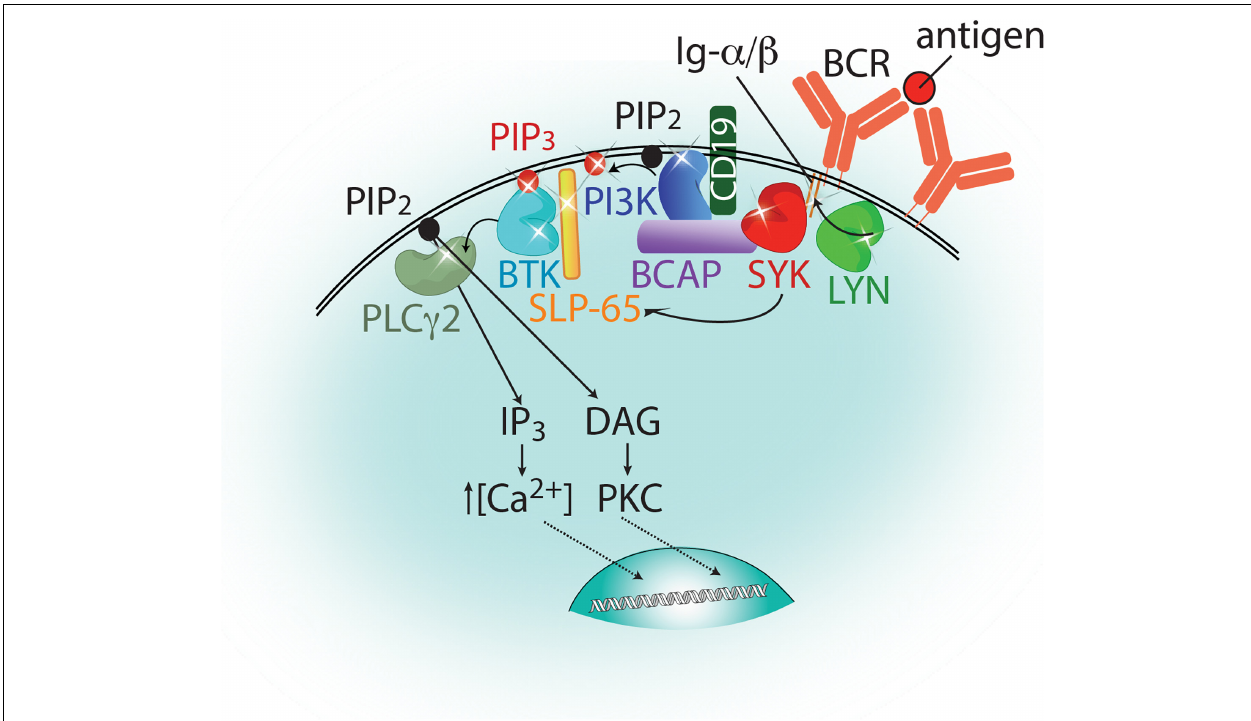
FIGURE 1 | Proximal signaling events emanating from the B cell receptor. Antigen binding to the B cell receptor (BCR, orange) leads to the activation of a trio of kinases: LYN, SYK, and BTK, which are represented as bi-lobed structures colored lime green, red, and cyan, respectively. Phosphorylation events carried out by these kinases are indicated by arrows and sites of phosphorylation are indicated as stars. These include phosphorylation of the ITAMs and CD19 (by LYN), BCAP and SLP-65 (by SYK), and PLC γ 2 (by BTK). PI3K, depicted in blue, phosphorylates PIP 2 to generate PIP 3 at the membrane. PIP 3 is indicated as a red circle and PIP 2 by a black circle. PLC γ 2 hydrolyzes PIP 2 at the membrane to produce the secondary messengers IP 3 and DAG which will induce a calcium flux into the cell and activate PKC, respectively. Further downstream signaling events that lead to an upregulation of target genes for B cell maturation and proliferation are not shown in this figure for